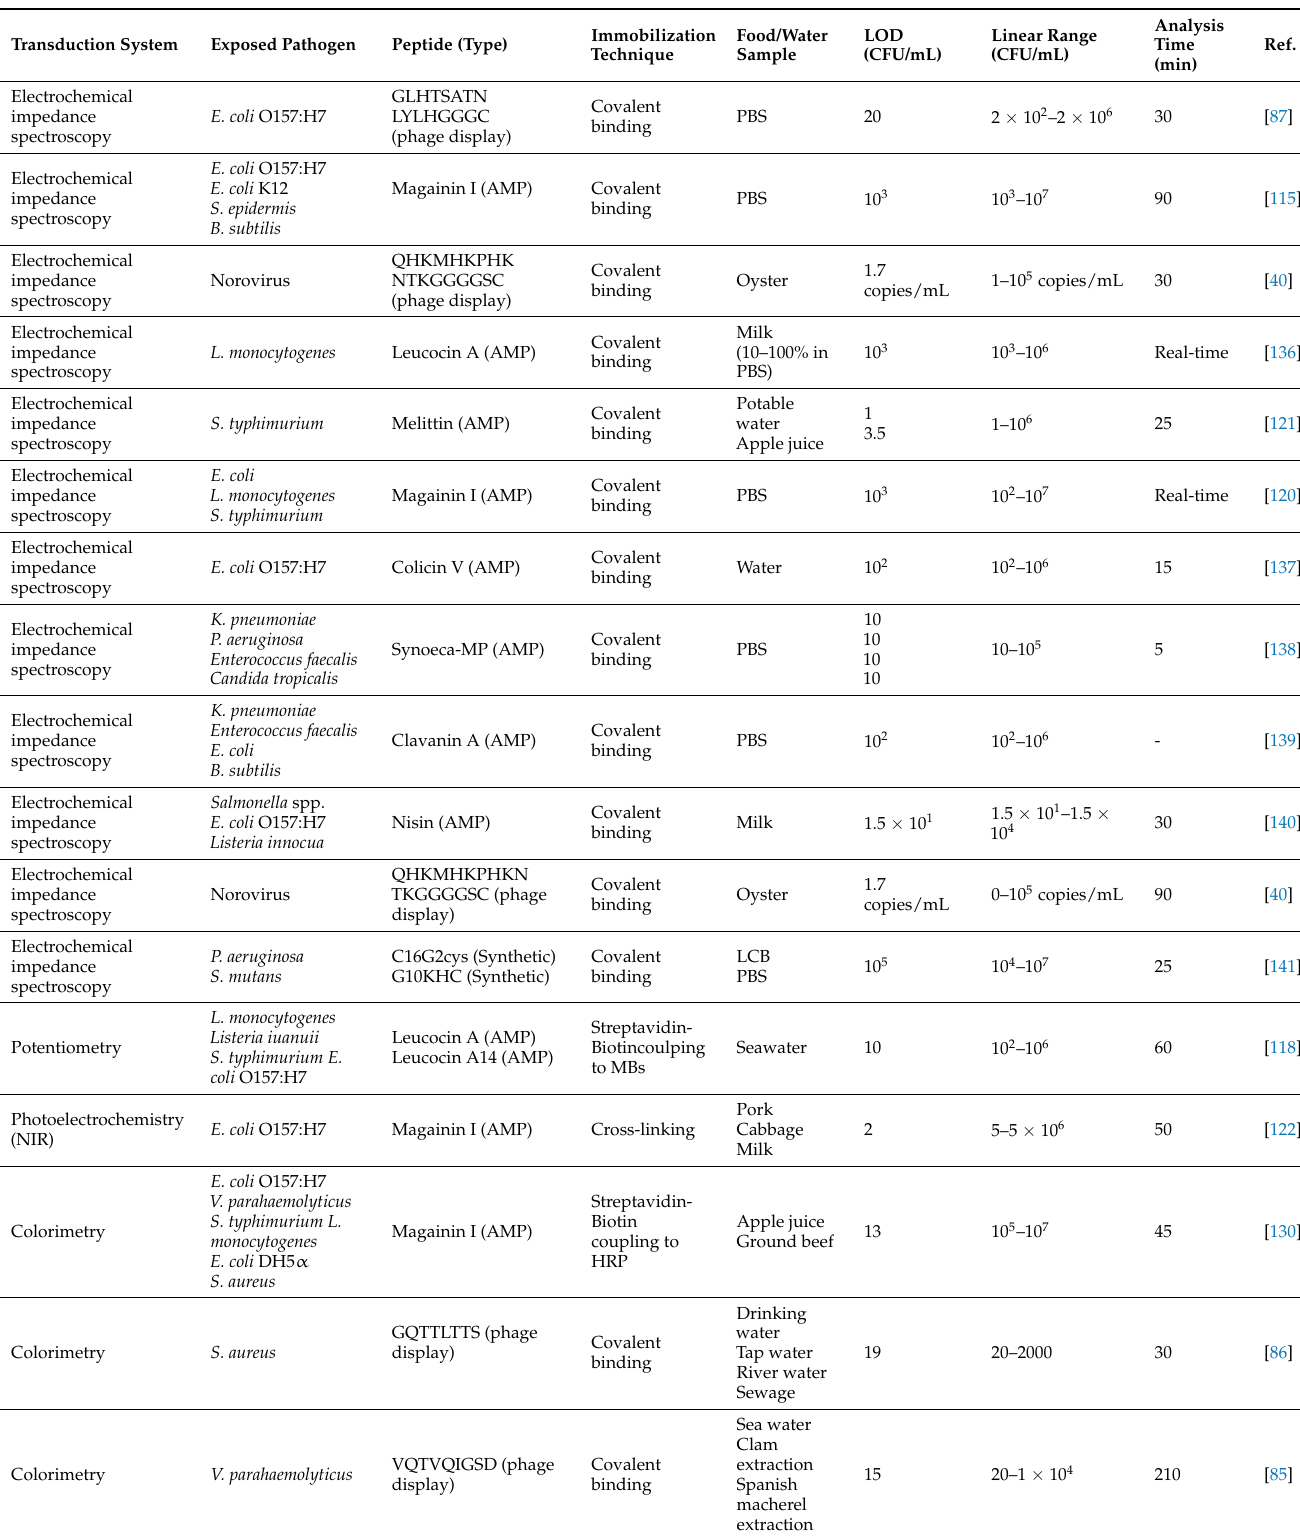
Table 4. Peptide-based biosensors for foodborne pathogen